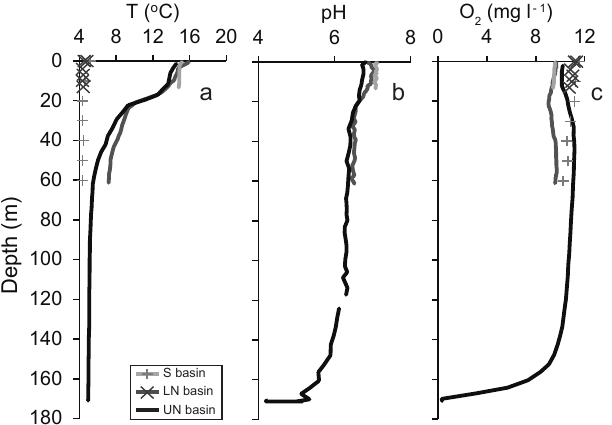
Figure 3. (a) Temperature, (b) pH and (c) dissolved-oxygen pro- files measured in September 2011 from the south (S), lower north (LN) and upper north (UN) basins. Additional markers represent data from S and LN basins in March, measured ex